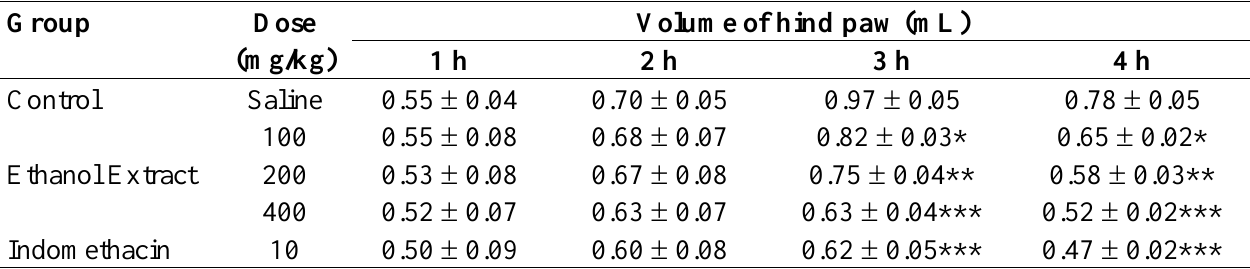
Table 2. Effects of the ethanol extract from M. platyclada leaves on carrageenan-induced paw edema in rats.